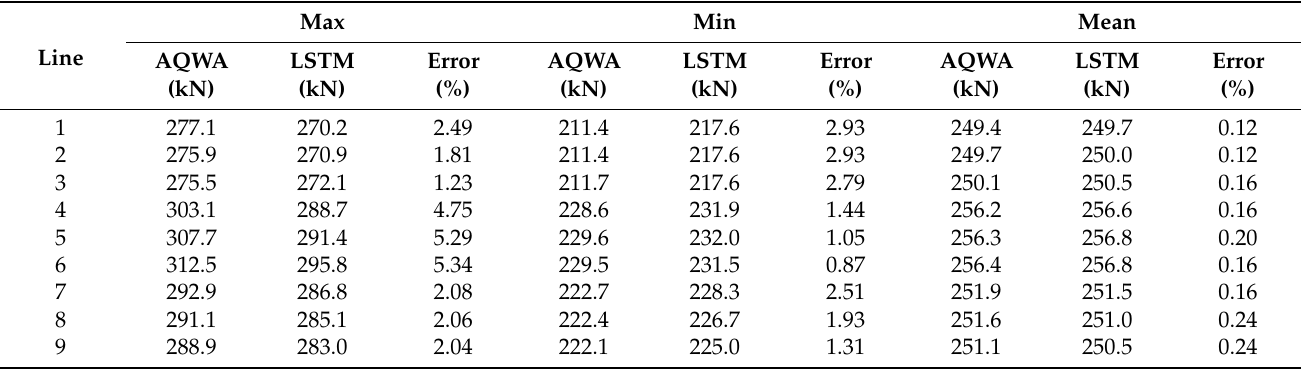
Table 11. Result statistics of case2.